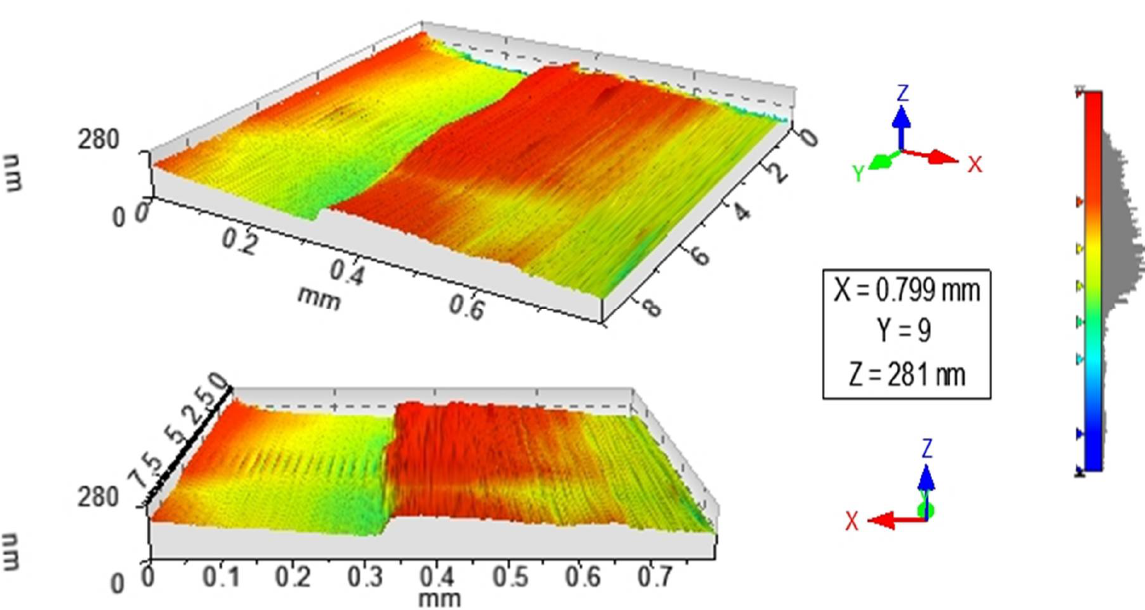
Figure 1. ( a , b ) Profilometry measurements at two different points of thin films of VO 2 on Al 2 O 3 .